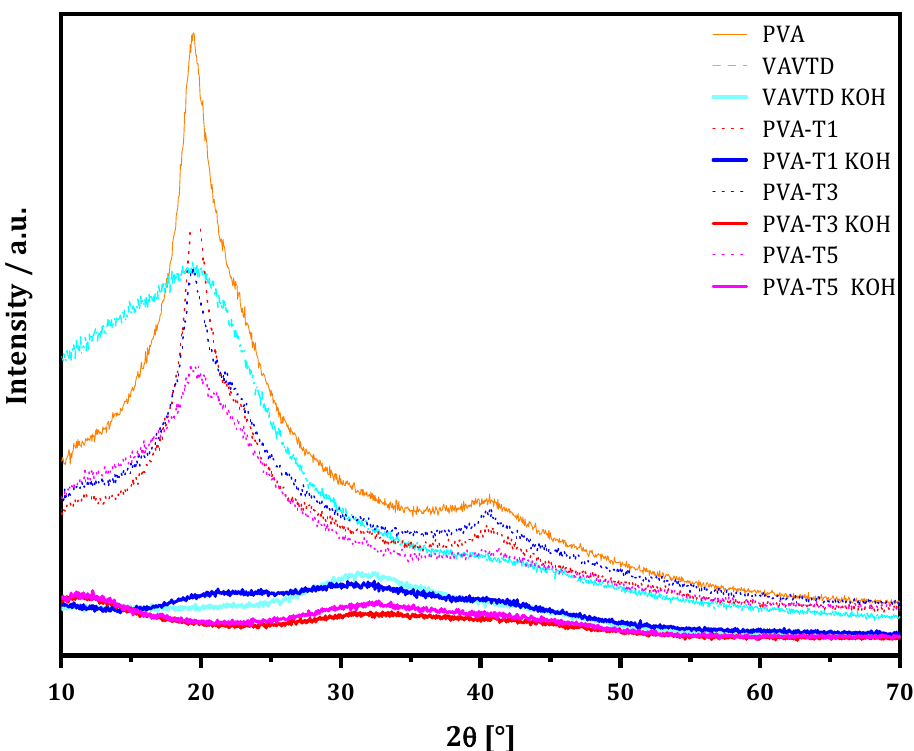
Figure 2. XRD patterns of PVA-VAVTD and PVA-VAVTD KOH systems at different VAVTD contents.